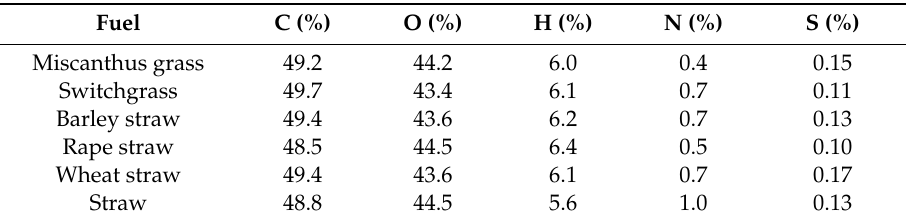
Table 1. Ultimate analysis of di ff erent plant biomass